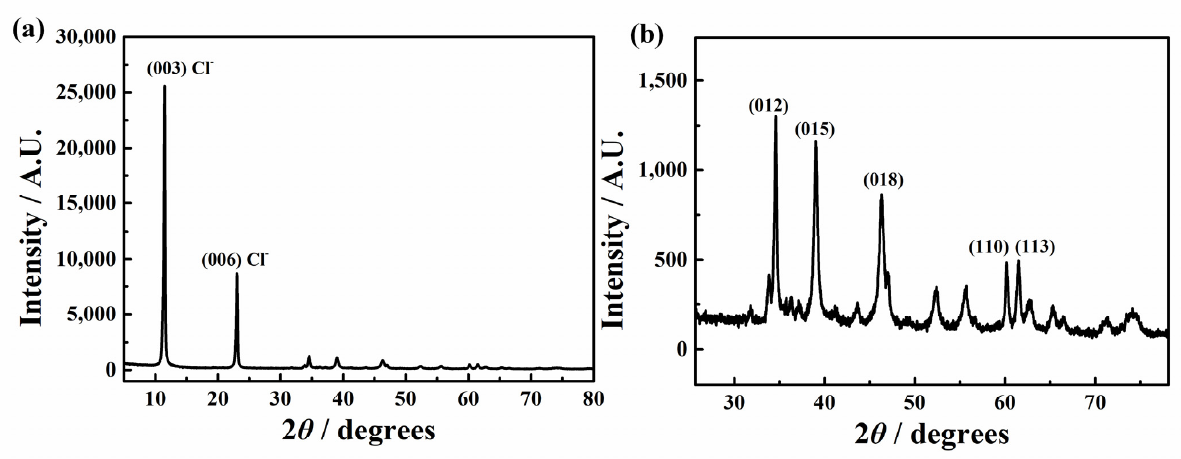
Figure 8. The XRD spectra of Zn2Al-LDH-15h after immersion in 0.02 mol/L NaCl solution for 80 h ◦ ; ( b ) from 25 to 78 ◦ ( a ) from 5 to 80°; ( b ) from 25 to 78°. ( a ) from 5 to 80